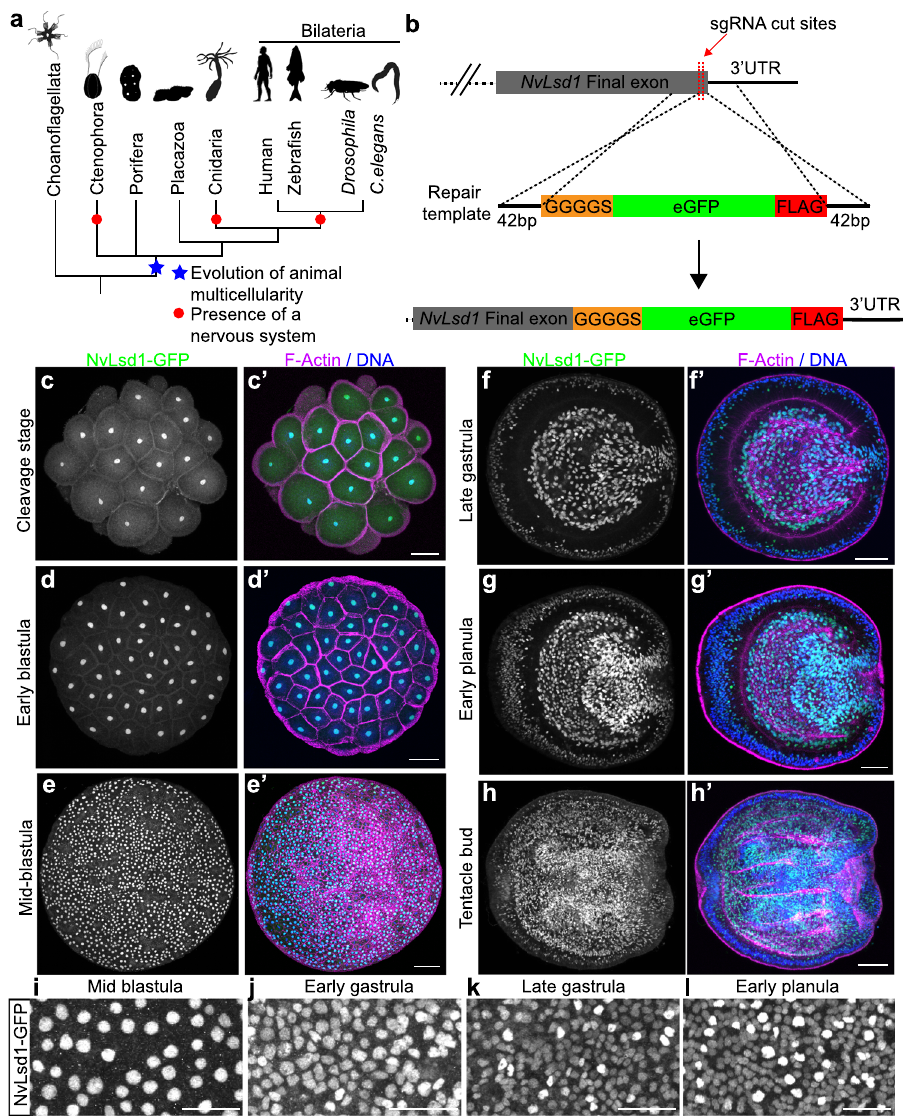
Fig. 1 NvLsd1 is ubiquitously expressed but developmentally regulated. a Reduced phylogeny showing the position of the four non-bilaterian animal lineages with respect to the Bilateria. The evolution of animal multicellularity is annotated by a blue star and the lineages possessing a nervous system are marked with a red circle. Phylogeny based on 39 , animal silhouettes are from http://phylopic.org/. b Schematic showing the strategy for generating the NvLsd1 GFP knock-in allele by CRISPR-Cas9-mediated homologous recombination. c – h Confocal images of immuno fl uorescence staining on NvLsd1 GFP animals. Stage is shown on the left. Oral is shown to the right in (f – h). NvLsd1-GFP is shown in green, DNA in blue and F-Actin in magenta. f – h show mid- samples from at least two independent replicates with >10 animals per